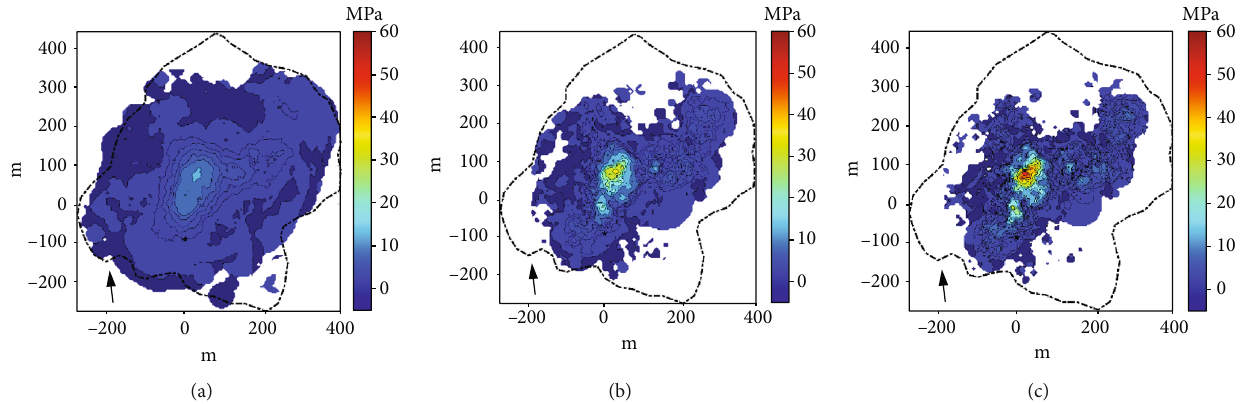
Figure 10: Spatial distribution of the maximum cumulative fl uid pressure changes inferred from repeated slip in top view of best- fi tting plane. Pressure changes are stated in megapascals according to the colour map, which is saturated at 60 MPa. The arrow indicates northern direction. A constant stress drop of (a) 0.1MPa, (b) 0.5MPa, and (c) 1.0MPa was assumed for determining fl uid pressure changes. Contour line denotes region of main seismic activity as outlined by the hypocentre distribution. Coordinates are given with respect to the top of Paralana-2 (30.21287 ° S/139.72850 °